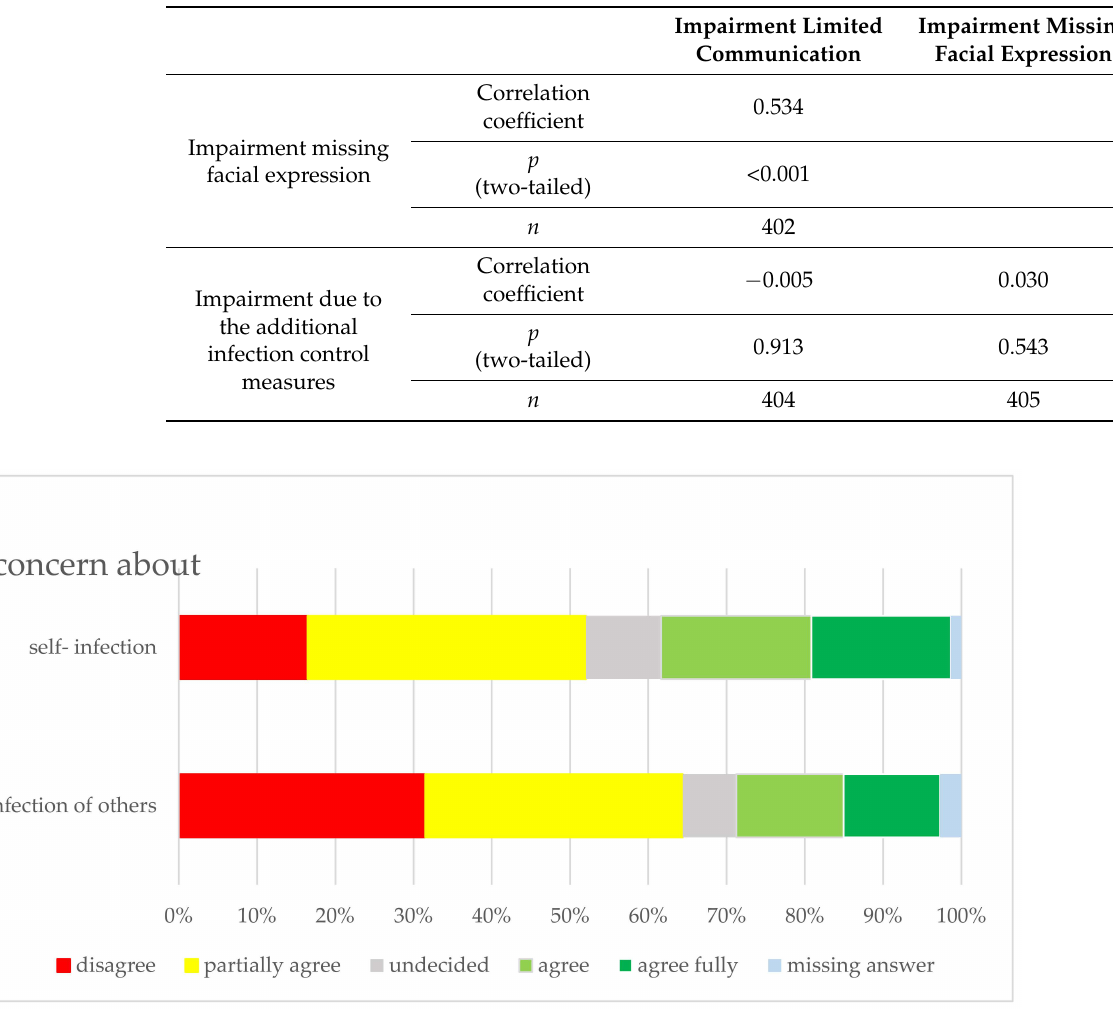
Figure 5. Participants’ assessment of the concern of self-infection and infection of